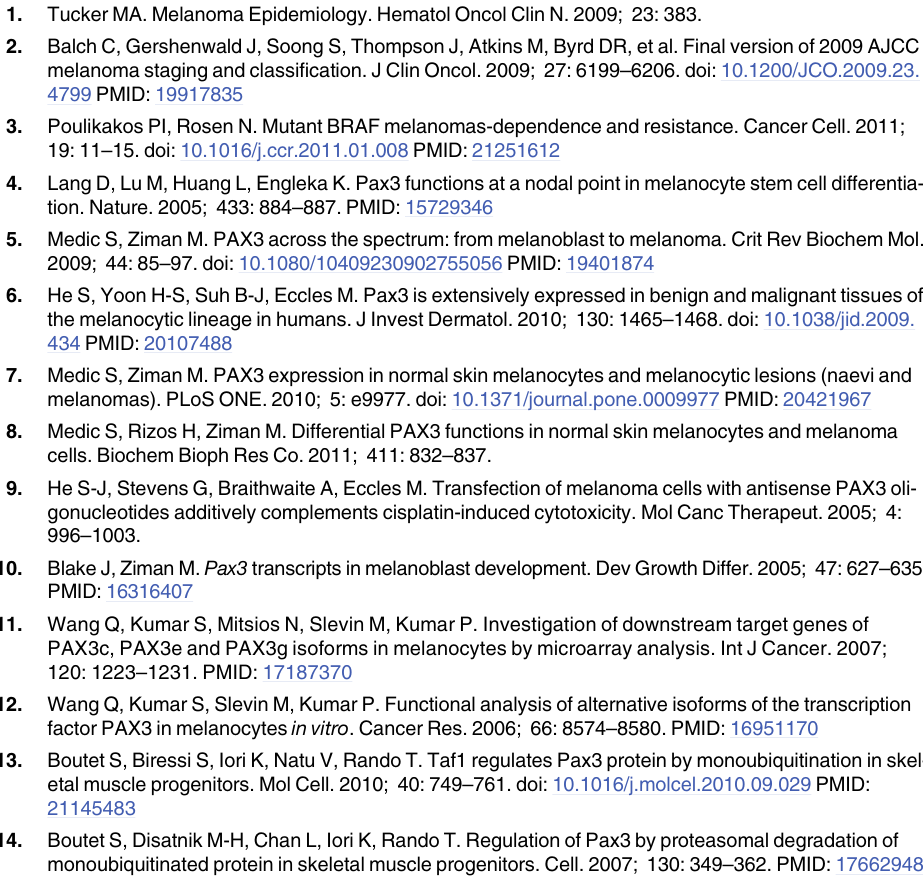
S1 Table. List of RT-qPCR primers used for analysis of the effect of PAX3 knockdown on previously identified downstream target